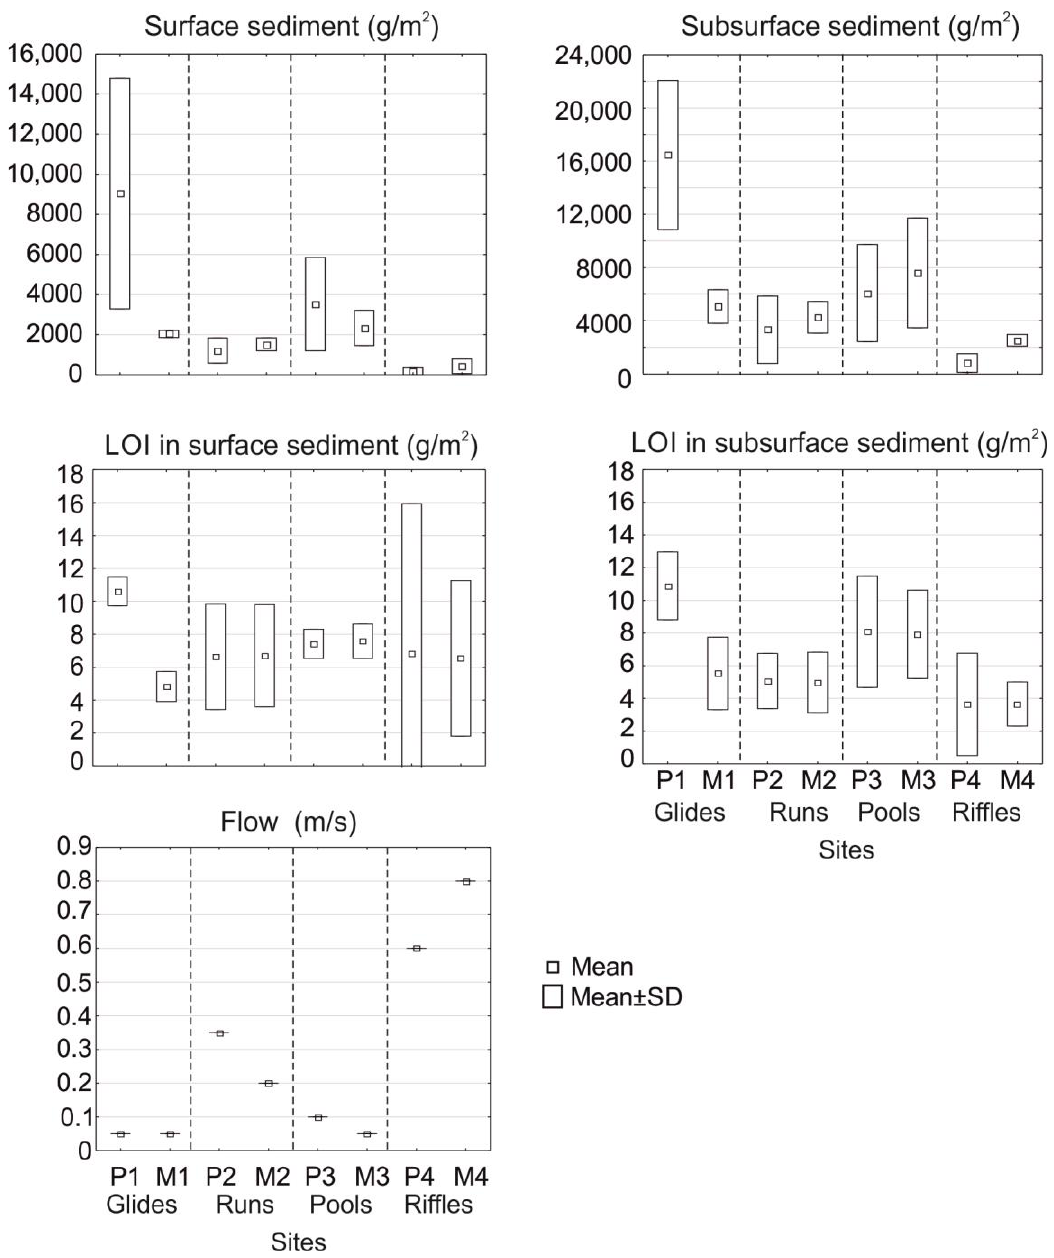
Figure 4. The values of environmental parameters in the Porębianka and Mszanka rivers.